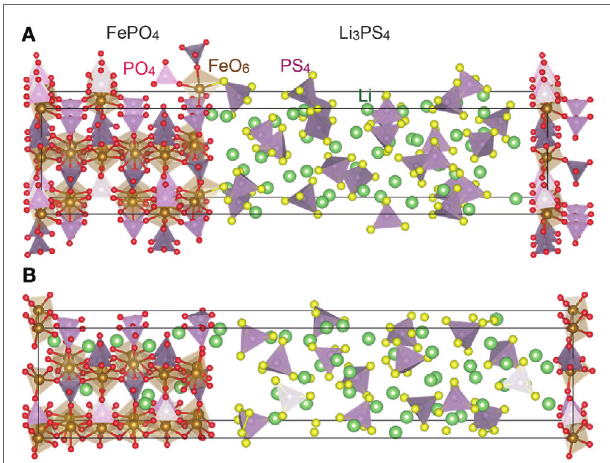
FigUre 5 | interface structure between FePO 4 and li 3 Ps 4 before (a) and after (B) the FP-MD . The crystal structures are drawn by a computer program, VESTA (Momma and Izumi,